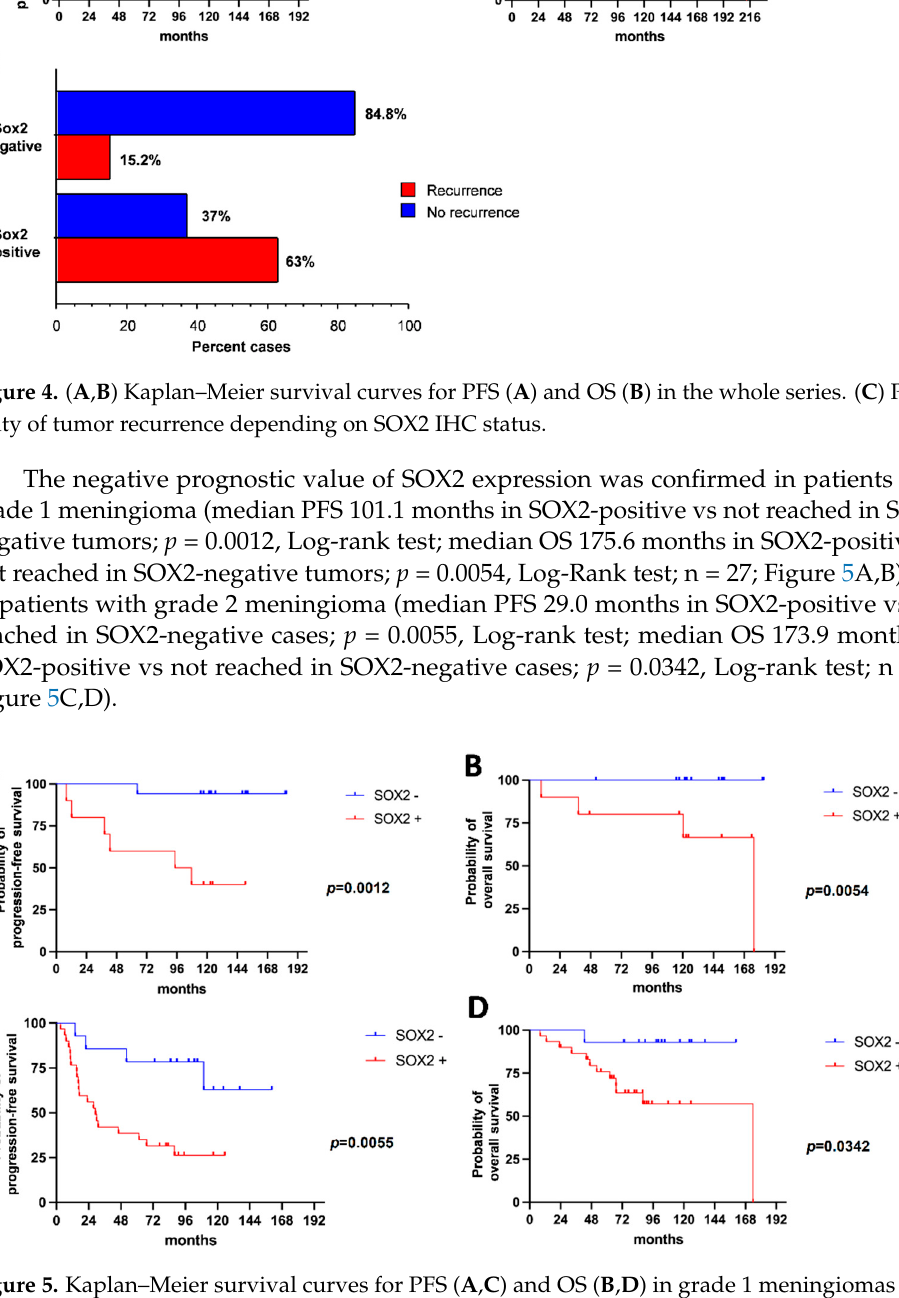
Figure 5. Kaplan–Meier survival curves for PFS ( A , C ) and OS ( B , D ) in grade 1 meningiomas ( A , B ) and in grade 2 meningiomas ( C , D